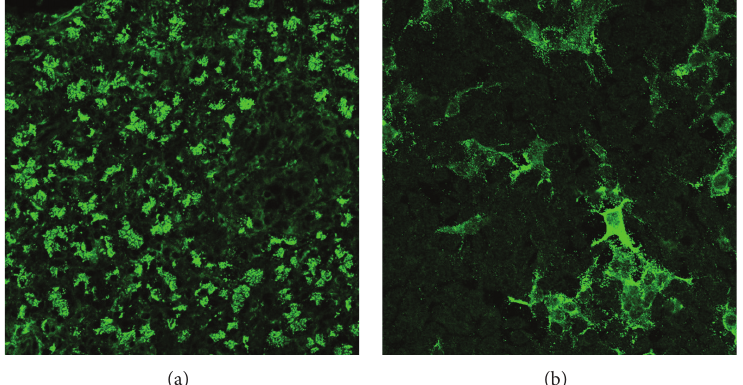
Figure 4: Immunofluorescence staining patterns of CUZD1-specific pancreatic autoantibodies giving a reticulogranular pattern using pancreatic tissue (a) or CUZD1-overexressed HEK3 cells